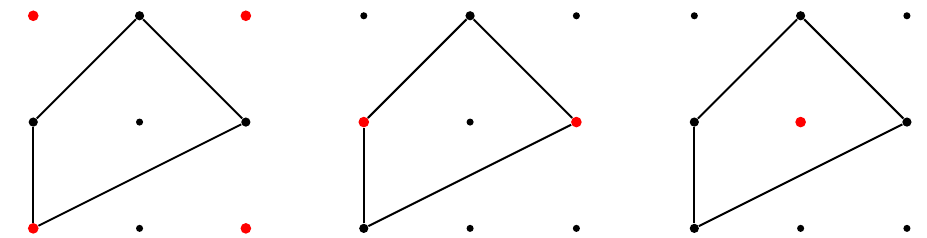
Figure 14. The various orientifold projections of toric diagram of dP 1 . The left (cid:12)gure shows the orientifold with a non-compact (cid:10)7 and (cid:10)3, in the center a non-compact (cid:10)7 and on the right a compact (cid:10)7.